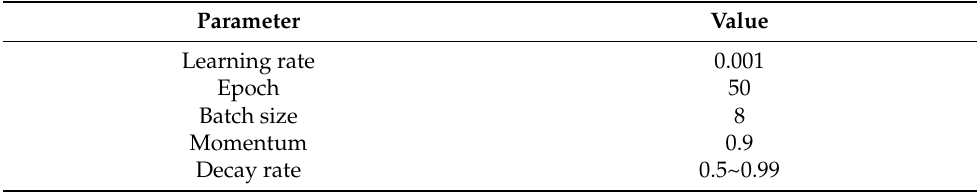
Table 2. Training